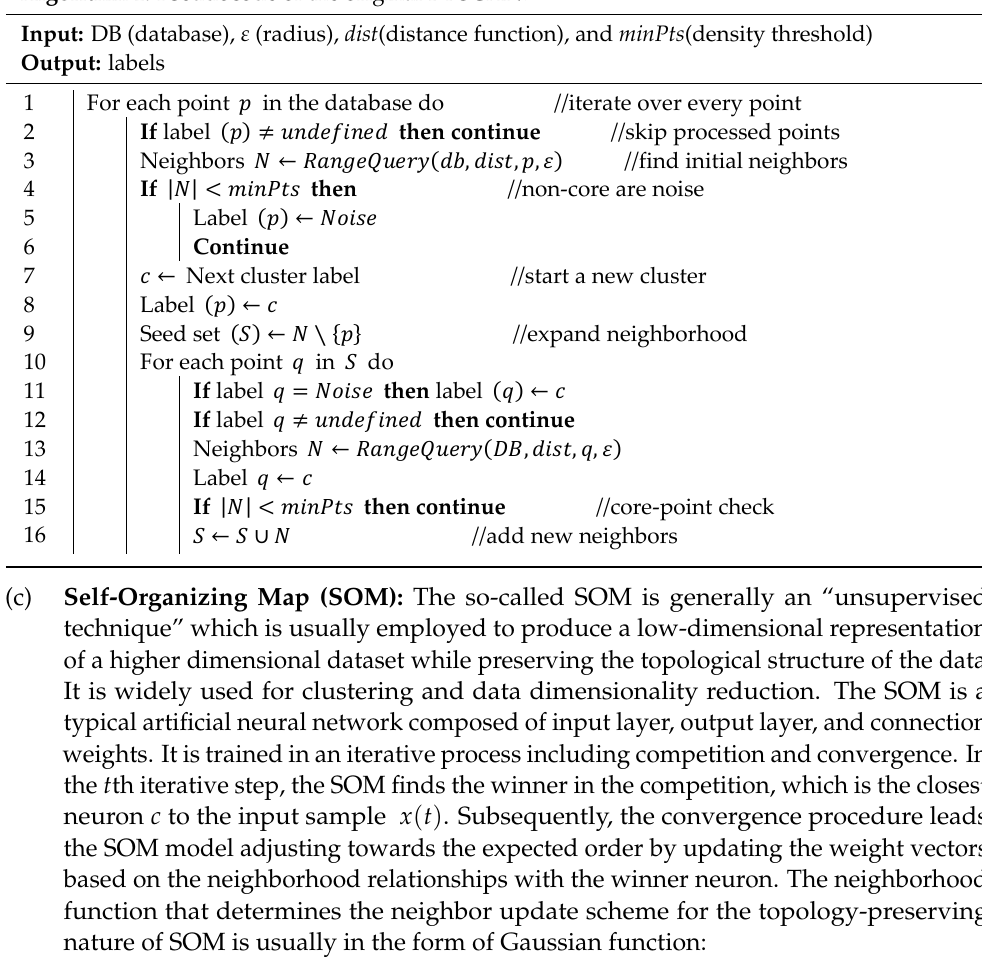
Algorithm 1: Pseudocode of the original DBSCAN.